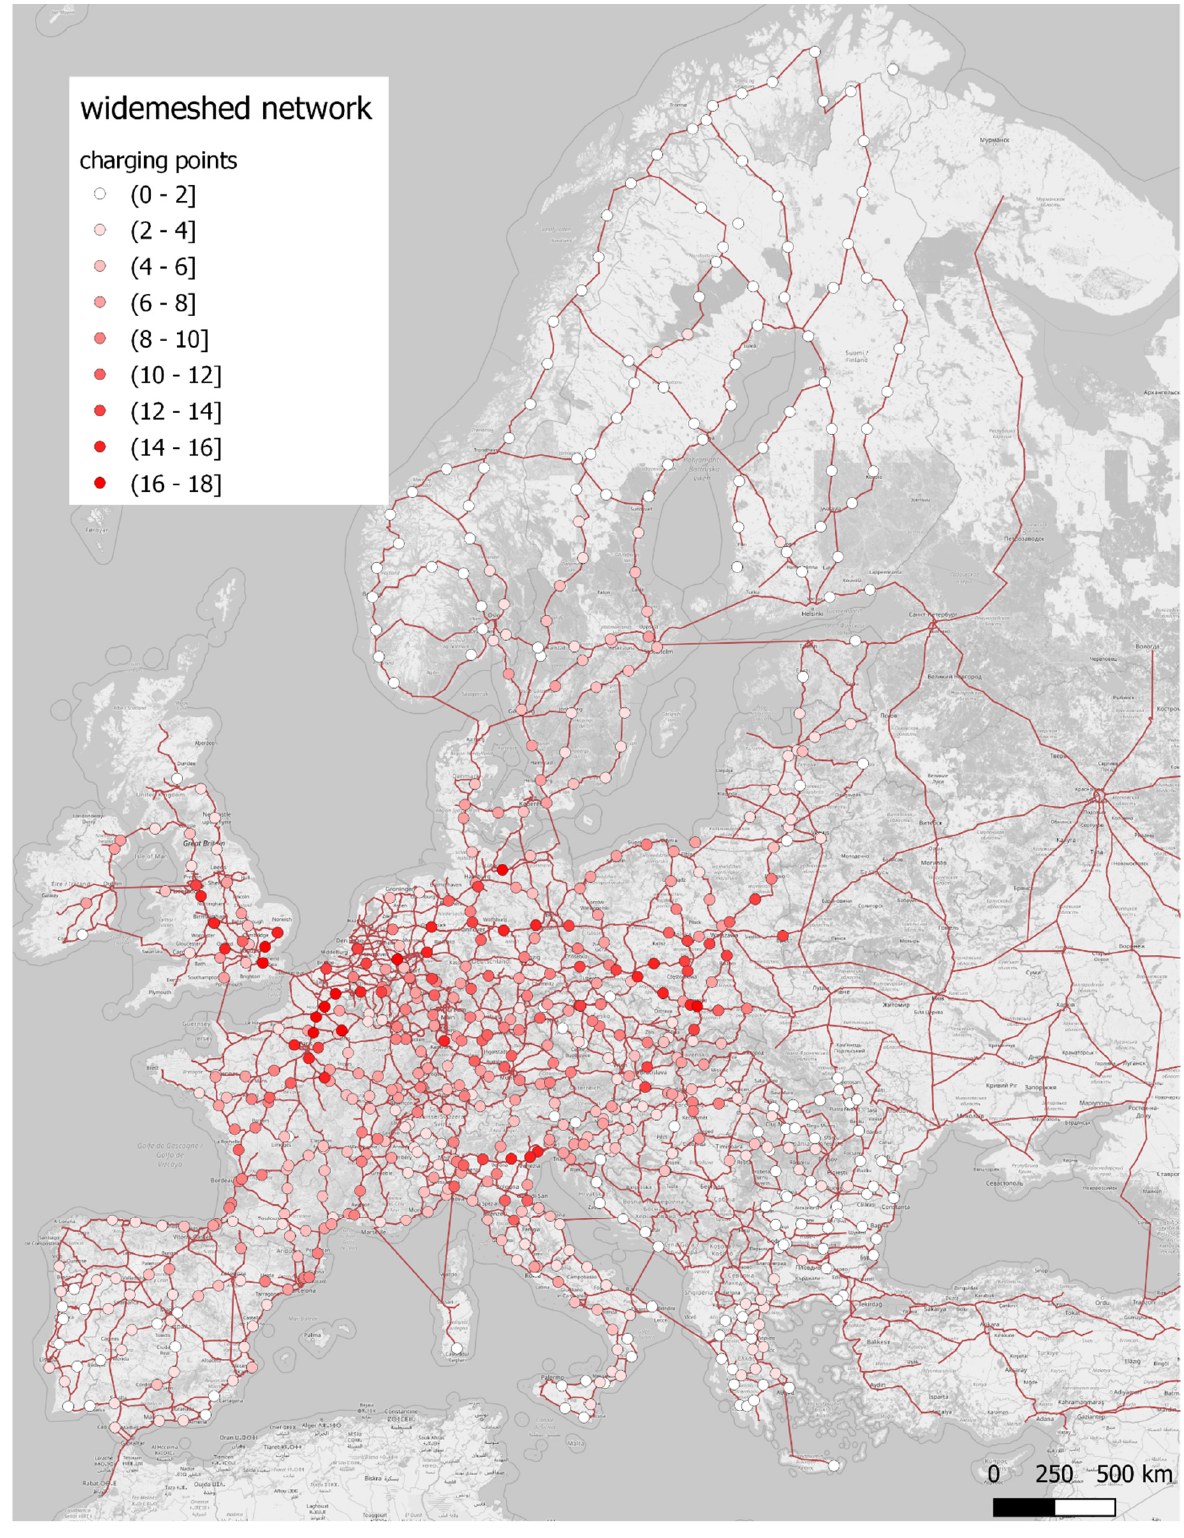
Figure 4. Location of 660 charging locations in the widemeshed network. Background: OpenStreetMap.